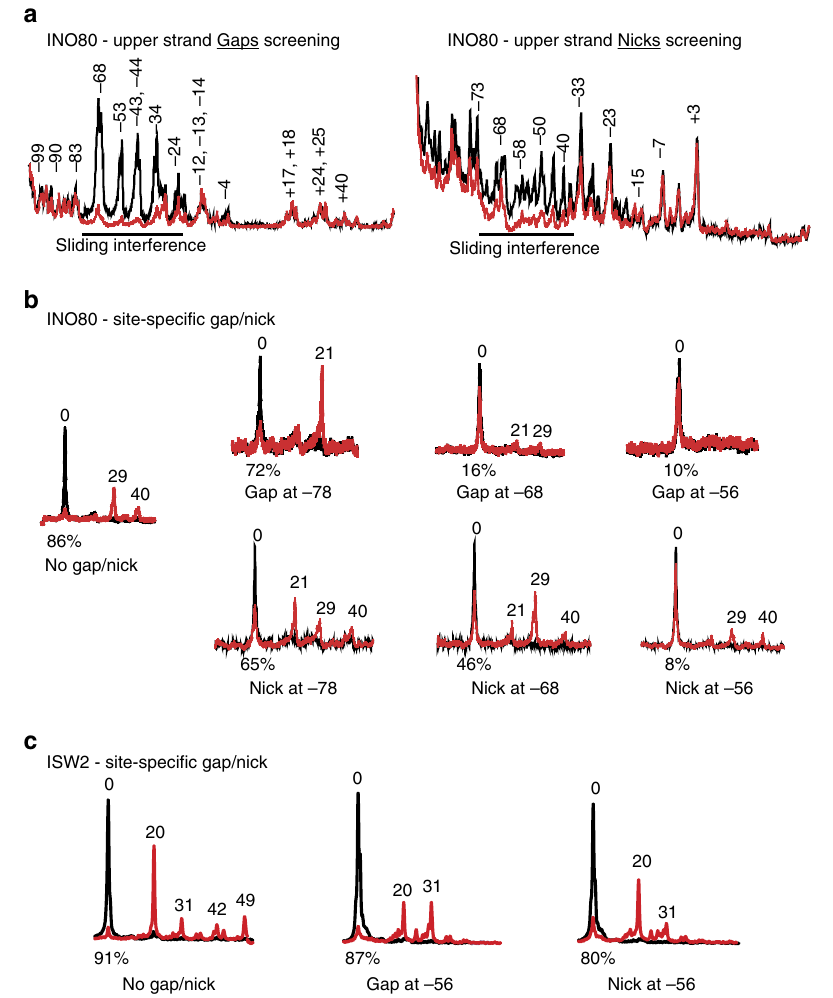
Figure 3 | Single nucleotide gaps and nicks in DNA at the H2A–H2B interface interfere with nucleosome mobilization by INO80. ( a ) The position(s) where DNA gaps and nicks interfere with INO80 remodelling were screened using 0N70 nucleosomes containing random gaps or nicks. The overlays show enrichment of DNA containing gaps or nicks at indicated positions with nucleosomes that were mobilized (red) versus those that were not (black). Nucleotide positions of the gaps and nicks are indicated relative to the dyad axis (0). Gaps and nicks that interfered with remodelling (underlined) were enriched in the immobile fraction. ( b ) Nucleosomes with a gap or nick in DNA at the specified positions in the upper strand were remodelled with INO80. Changes in nucleosome position were mapped by site-directed cleavage. The cleavage sites were mapped before (black) and after (red) INO80 remodelling 57 . The original position of the nucleosome is denoted as 0 and numbers indicate bp moved. Fractions (%) of the original nucleosome position lost due to remodelling are indicated. ( c ) Effects of a single gap or nick at nt (cid:2) 56 on ISW2 remodelling were examined as for INO80 (refer to b ). Data are representative of four technical replicates for a and three technical replicates for b , c